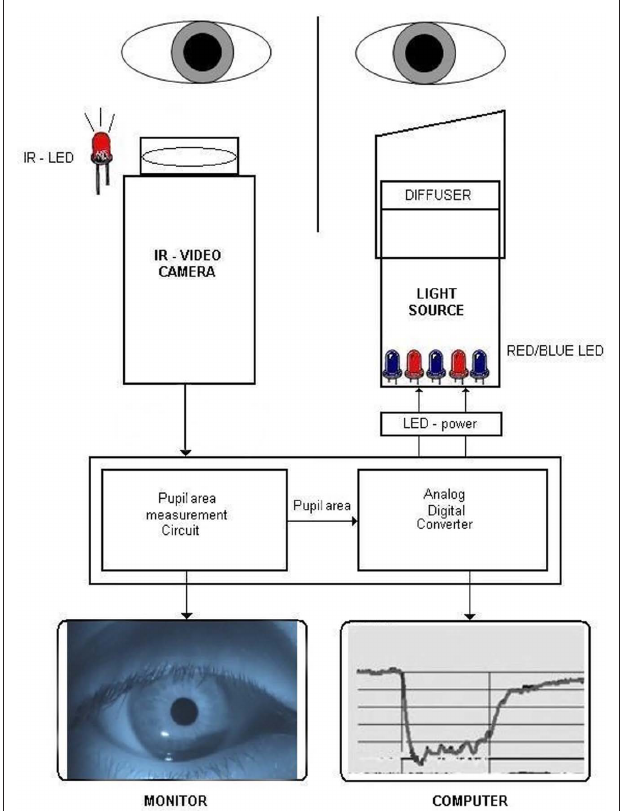
Figure 1 | Diagram of the chromatic pupillometer apparatus. One eye is stimulated with colored light (blue or red) and the pupil response is recorded on the consensual eye by an infrared video camera under infrared illumination. The light stimulator is time locked to the recording system which is computer-controlled. During the pupil recording, real-time pupil movements can be observed on the LCD monitor and at the same time in graphic form on computer screen. IR, infrared; LED, light emitting